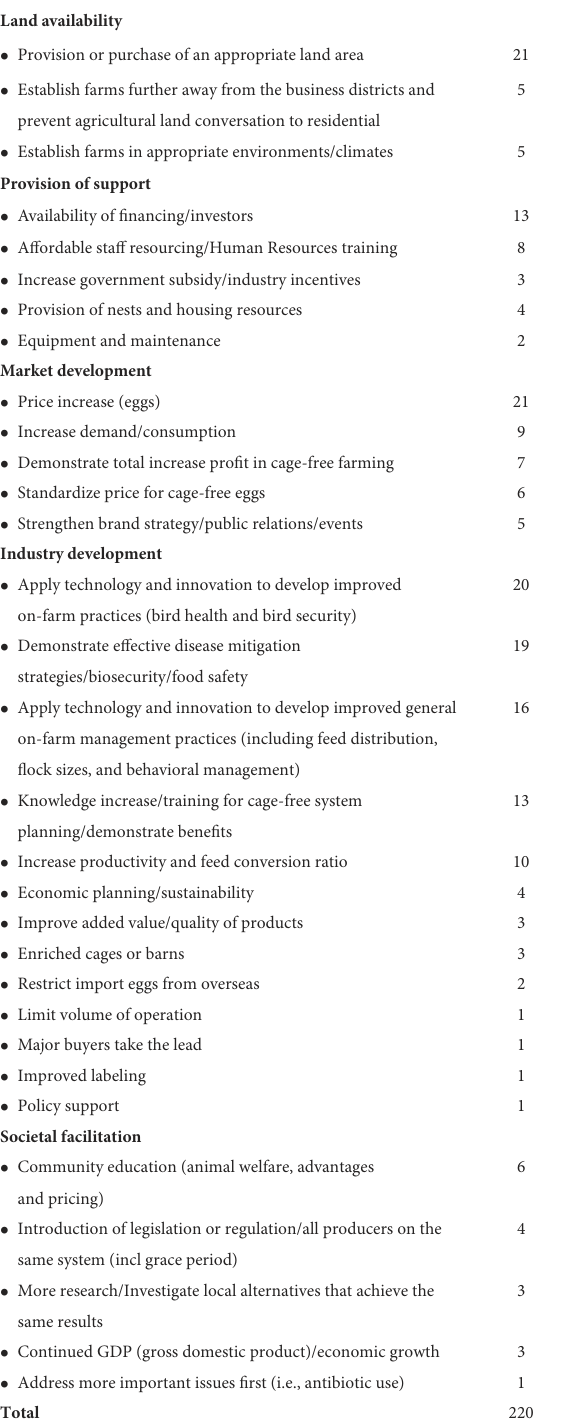
TABLE 4 Frequency of perceived solutions to overcoming the aforementioned barriers that prevent cage farmers from using cage-free systems.